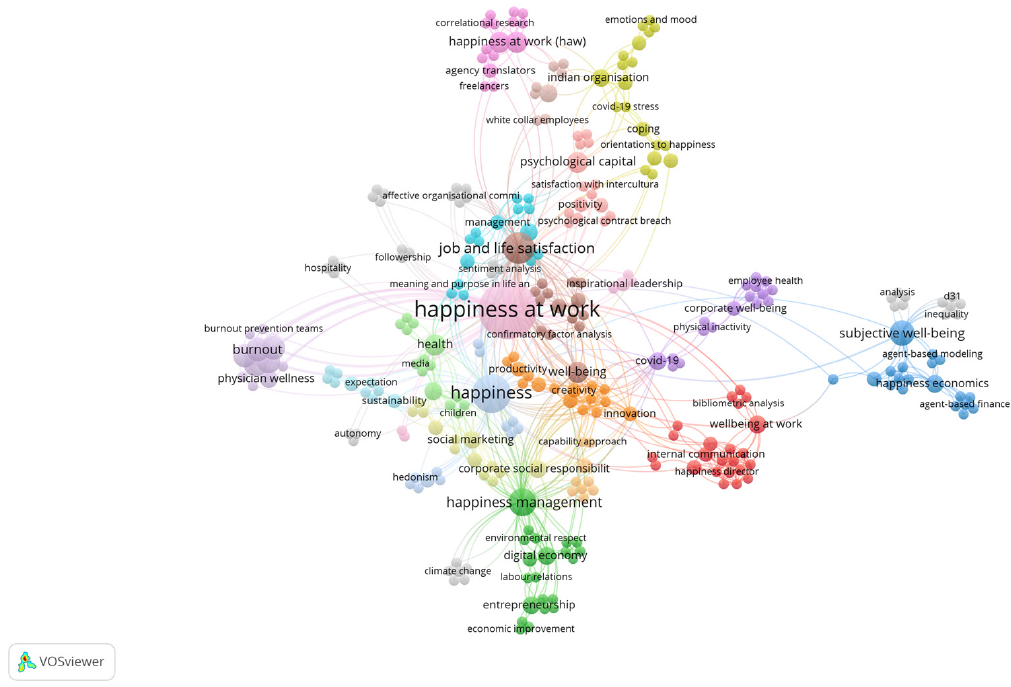
Figure 7. Keyword co-occurrence maps; period: